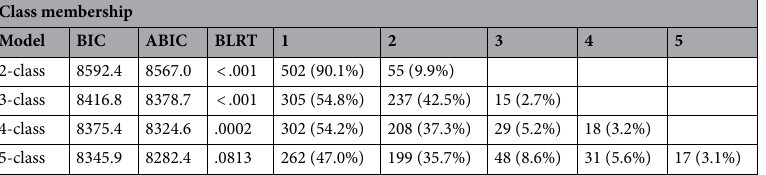
Table 1. Fit statistics and class membership for the identification of PD cases (n = 557). PD: Positive Deviant; BIC: Bayesian Information Criterion; ABIC: Adjusted Bayesian Information Criterion; BLRT: Bootstrapped Likelihood Ratio Test for k versus k–1 classes; class membership is sorted from largest to smallest.